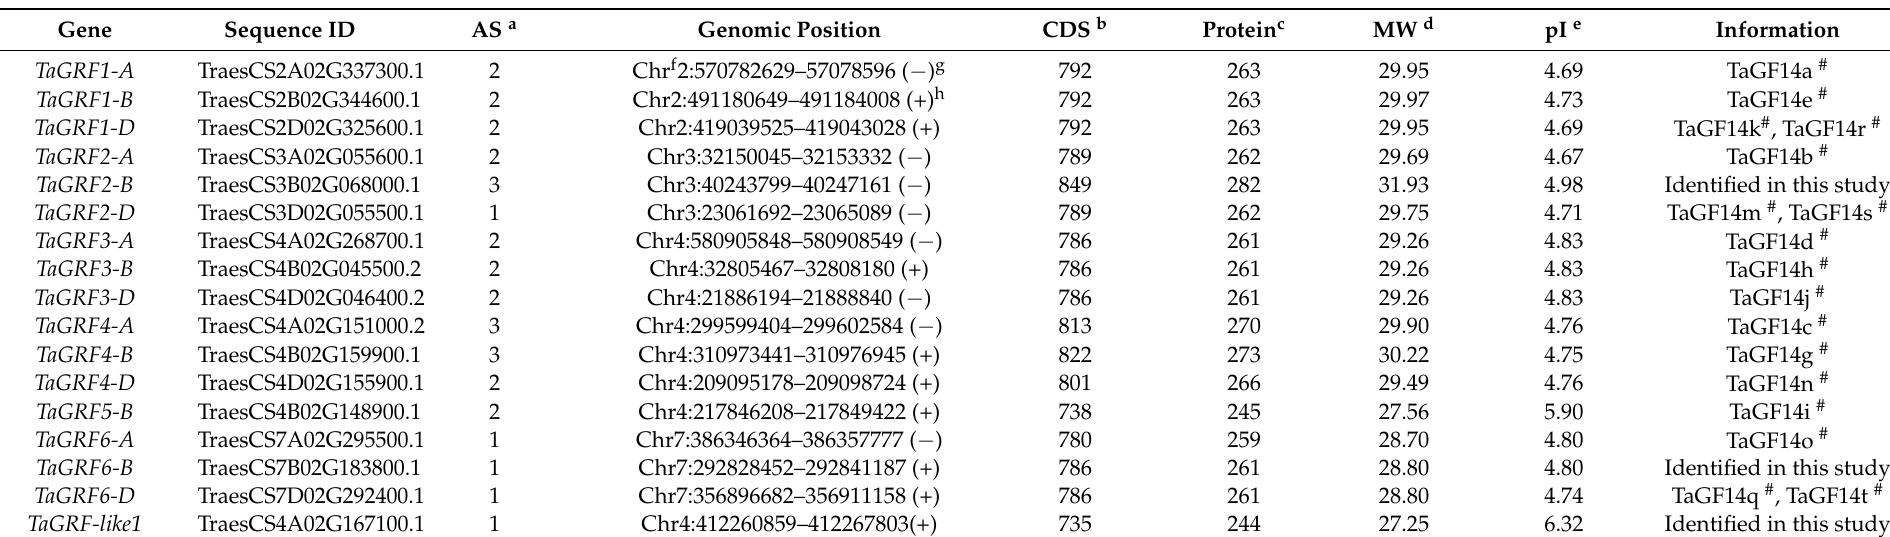
Table 1. Detailed information of putative